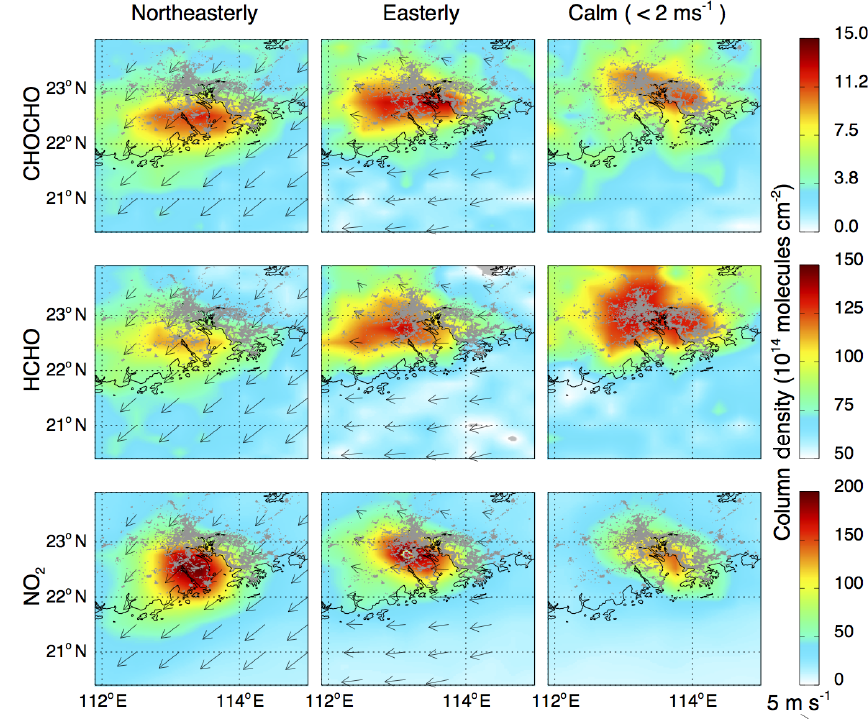
Figure 3. Mean OMI vertical column densities of CHOCHO, HCHO, and NO 2 over the PRD for 2006 to 2007, segregated by wind direction. Wind vectors at 60m altitude are from the NASA GEOS-5 assimilated meteorology product. The distribution of urban land cover from the MODIS type 5 land cover product is shown in